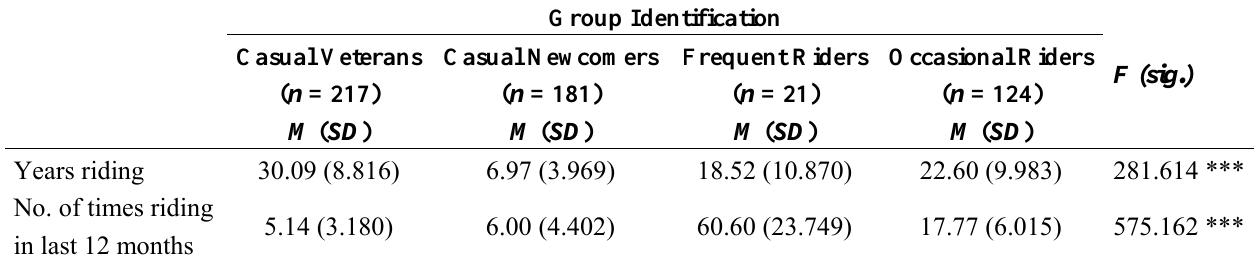
Table 1. Comparison of experience use history (EUH) groups. Group Identification